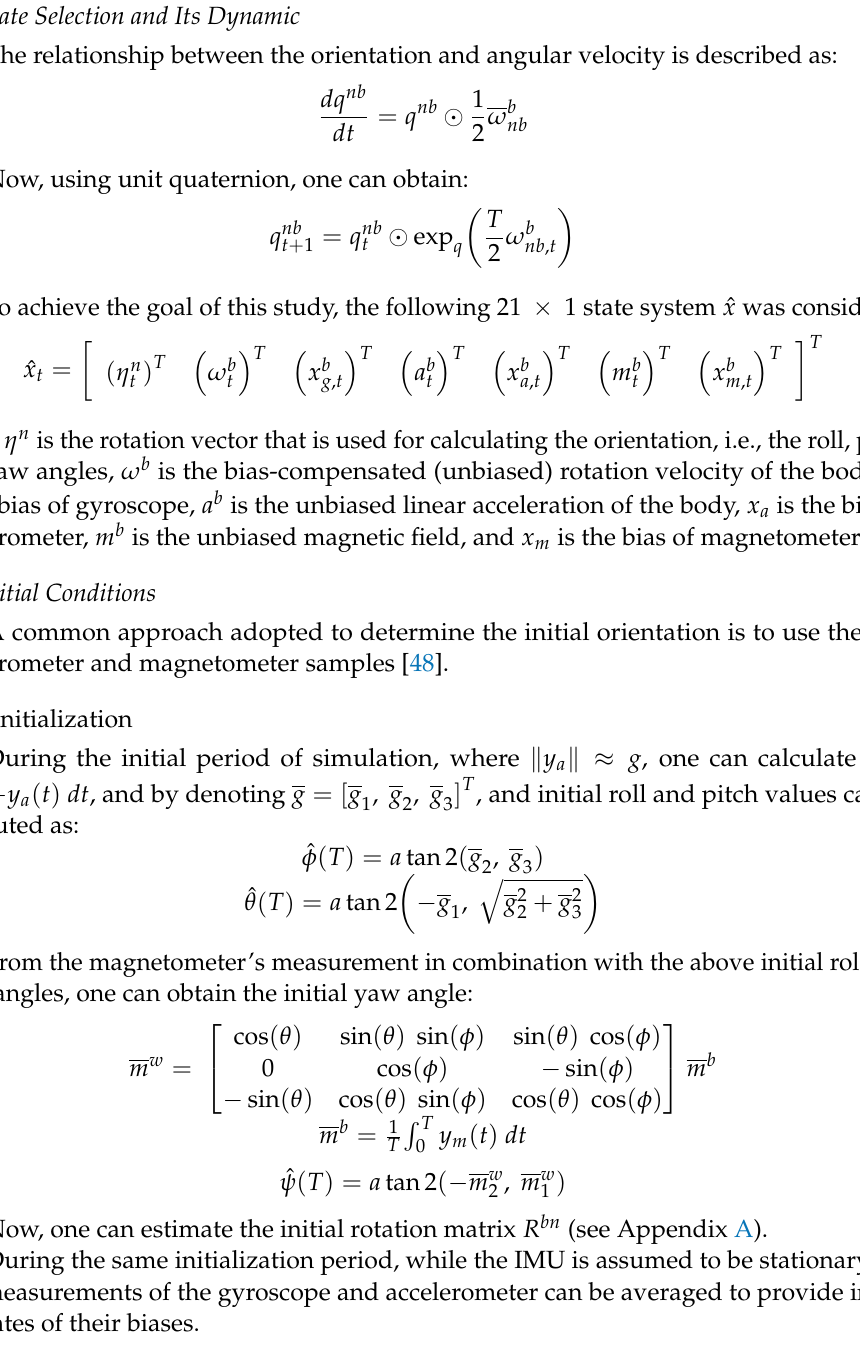
Figure 3. Schematic representation of the Dip angle (the blue dashed line refers to the horizontal component of the magnetometer location).